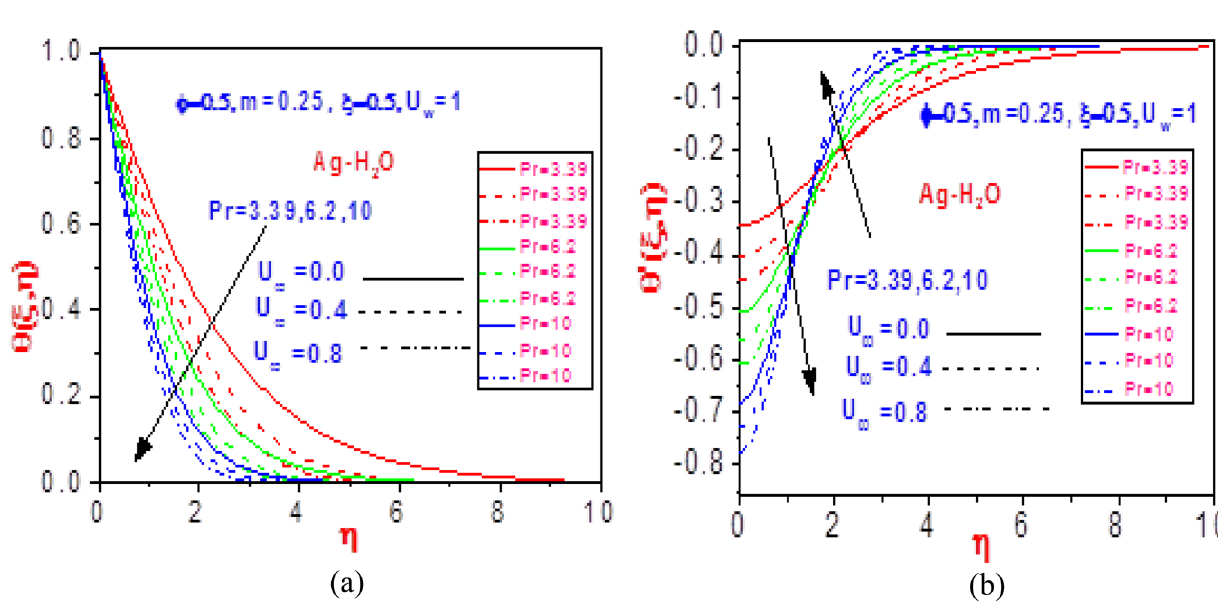
Figure 10. Profiles of ( a ) temperature θ(ξ , η) and ( b ) missing temperature slope θ ′ (ξ , η) with different values of U ∞ and Pr for